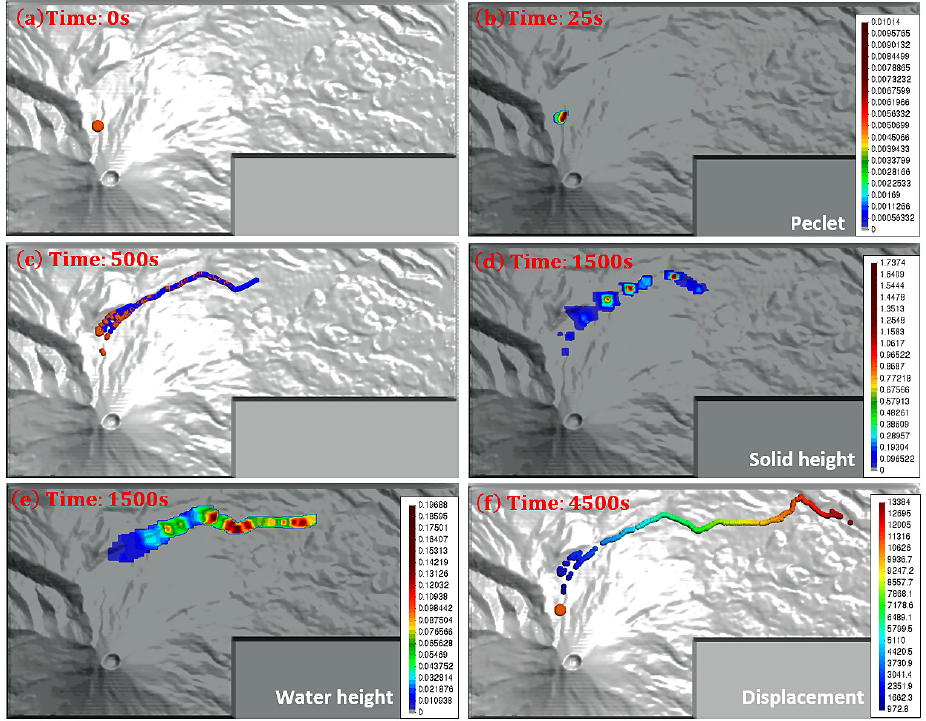
Figure 10. ( a ) The terrain and the initial mass, ( b ) basal Péclet number at time 25 s, ( c ) overtaking the liquid phase over the solid phase, ( d ) the propagation height of the solid phase (m) at the time 1500 s, ( e ) the propagation height of the fluid phase (m) at the time 1500 s, and ( f ) the lahar reaching the final deposition with the computed run-out distance